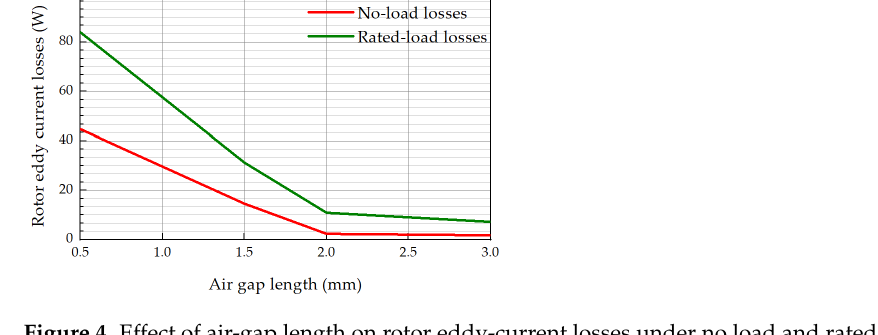
Figure 4. Effect of air ‐ gap length on rotor eddy ‐ current losses under no load and rated load.